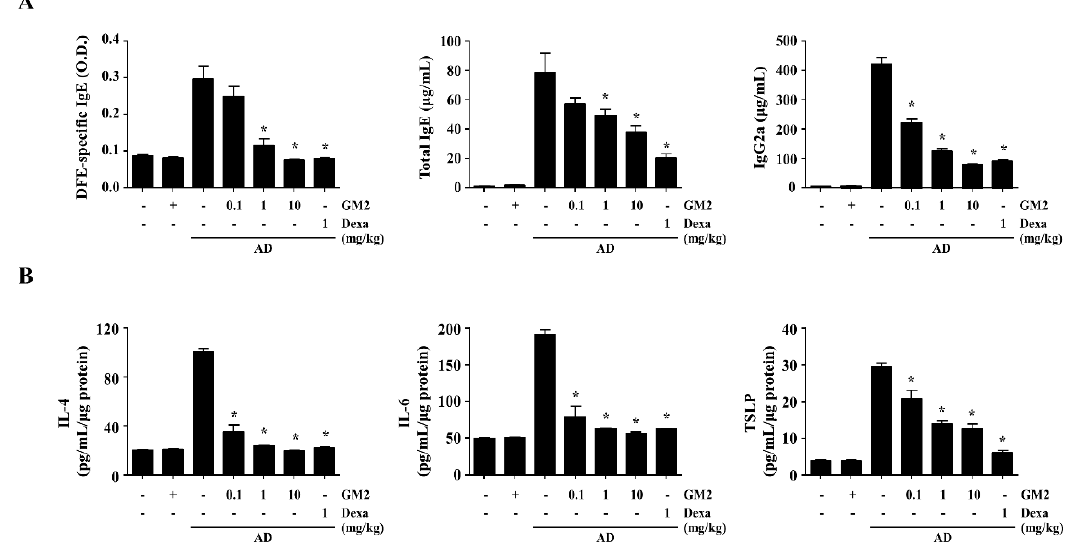
Figure 5. Effect of GM2 on the levels of sera immunoglobulin and tissue extracts of AD mice. Blood samples were collected from the abdominal vena cava and ear tissue samples were removed per mouse from each group on day 28. Each graph demonstrates the levels of DFE-specific IgE, total IgE, and IgG2a in serum ( A ) and the levels of IL-4, IL-6, and TSLP proteins in ear tissue extracts ( B ) were determined using ELISA. Data presented in the graph represents the means ± SEM ( n = 5). * p < 0.05, compared with the DNCB/DFE-induced group. Dexa: dexamethasone.